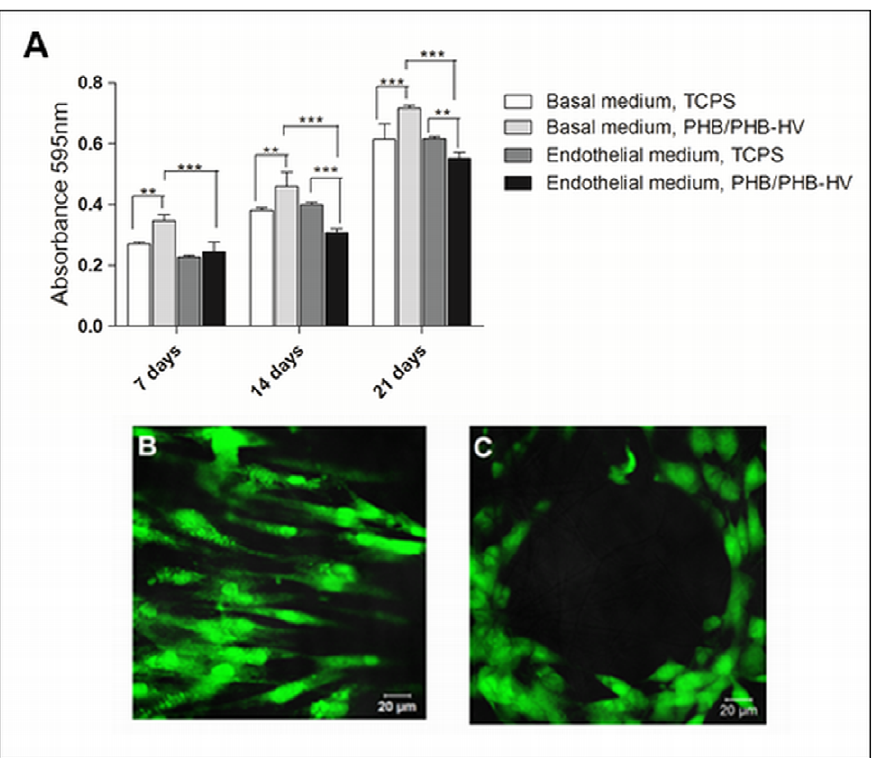
Figure 4. Proliferation and viability of hASCs cultured on TCPS and electrospun PHB/PHB-HV fiber mesh. (A) MTT proliferation assays performed 7, 14 and 21 days after the cell seeding and cultured in two specific medium: the basal medium and the endothelial differentiation medium. The results are expressed as the means 6 SD, (*) indicating a significant difference with p , 0.05, (**) p , 0,01, (***) p , 0,001; (B) cell viability after 21 days of cell culture with the basal medium and (C) the endothelial differentiation medium on the electrospun PHB/PHB-HV fiber mesh, as analyzed by Calcein-AM staining.